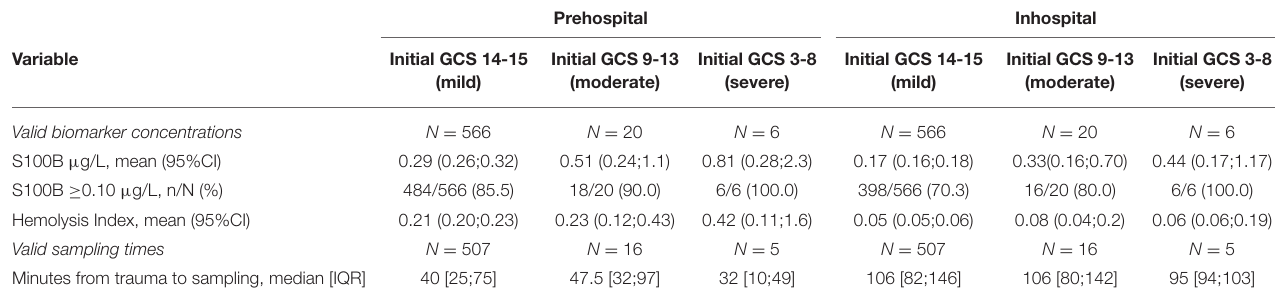
TABLE 2 | S100B concentrations and sampling times in prehospital and in-hospital serum samples from patients with TBI stratified by GCS, N = 592. Prehospital Inhospital